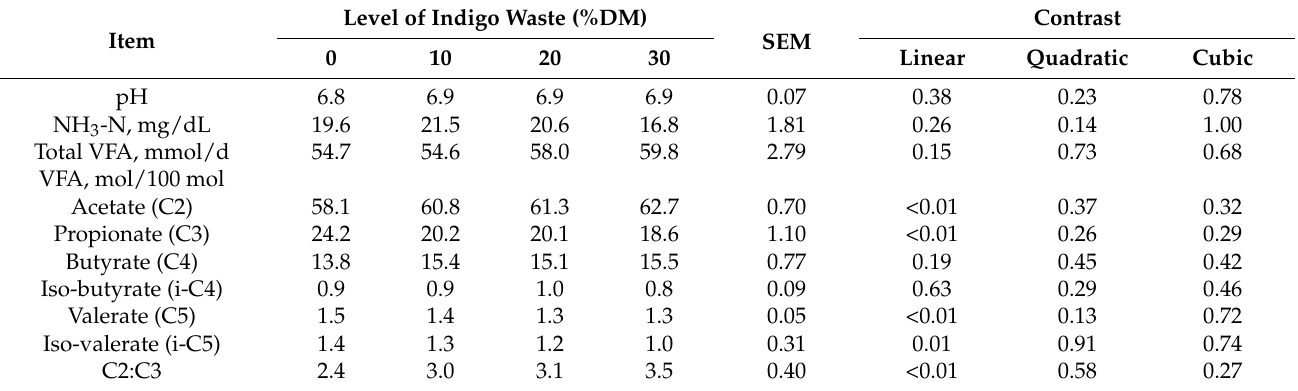
Table 7. Effect of indigo waste on rumen fermentation in growing beef